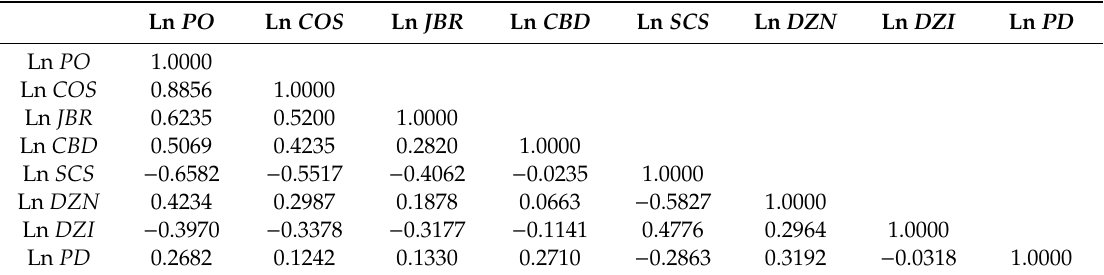
Table 3. Correlations between independent and control